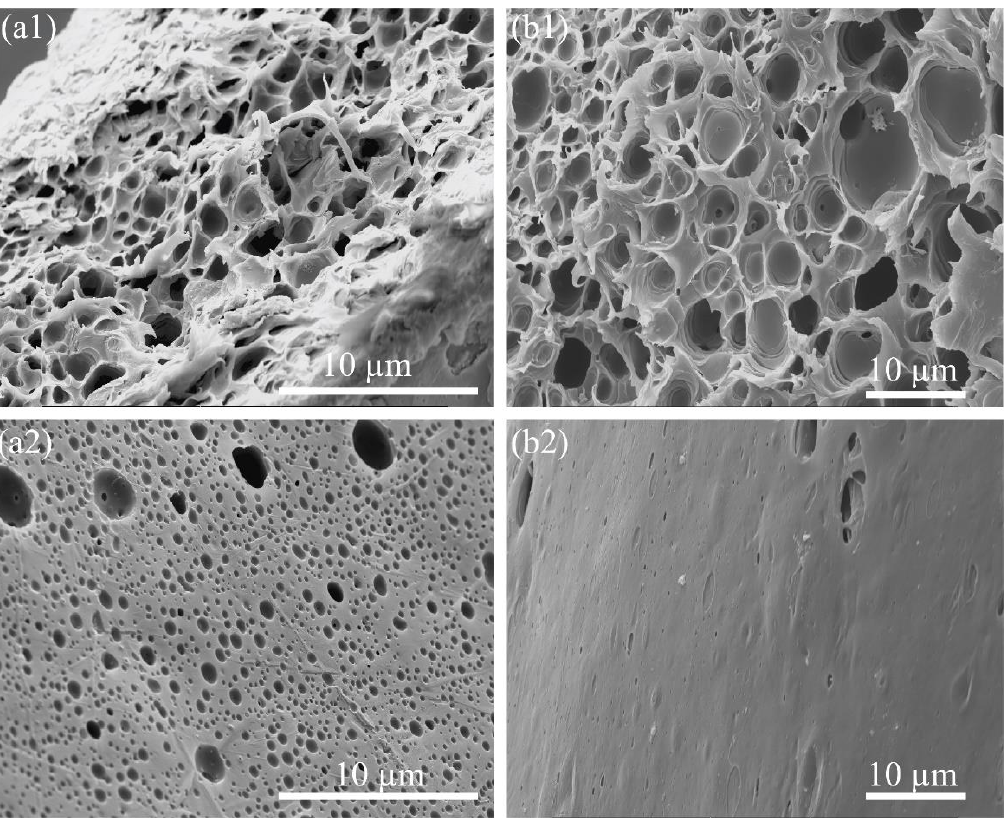
Figure 4. SEM images showing ( a ) 10 wt. % PEG/35 wt. % PS p-HM and ( b ) 10 wt. % PEG/35 wt. % PS f solutions were injected as fibers and soaked in water for 24 h. ( a1 , b1 ) Cross-section areas, and ( a2 , b2 ) surface areas.